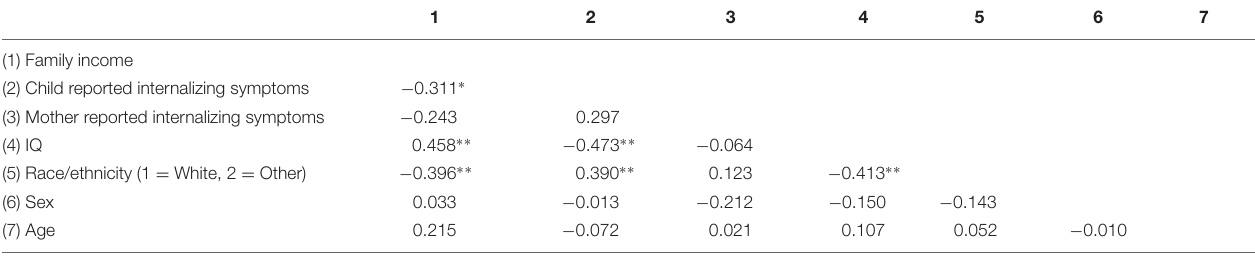
TABLE 2 | Bivariate correlations between family income, child internalizing symptoms, and demographic variables. 1